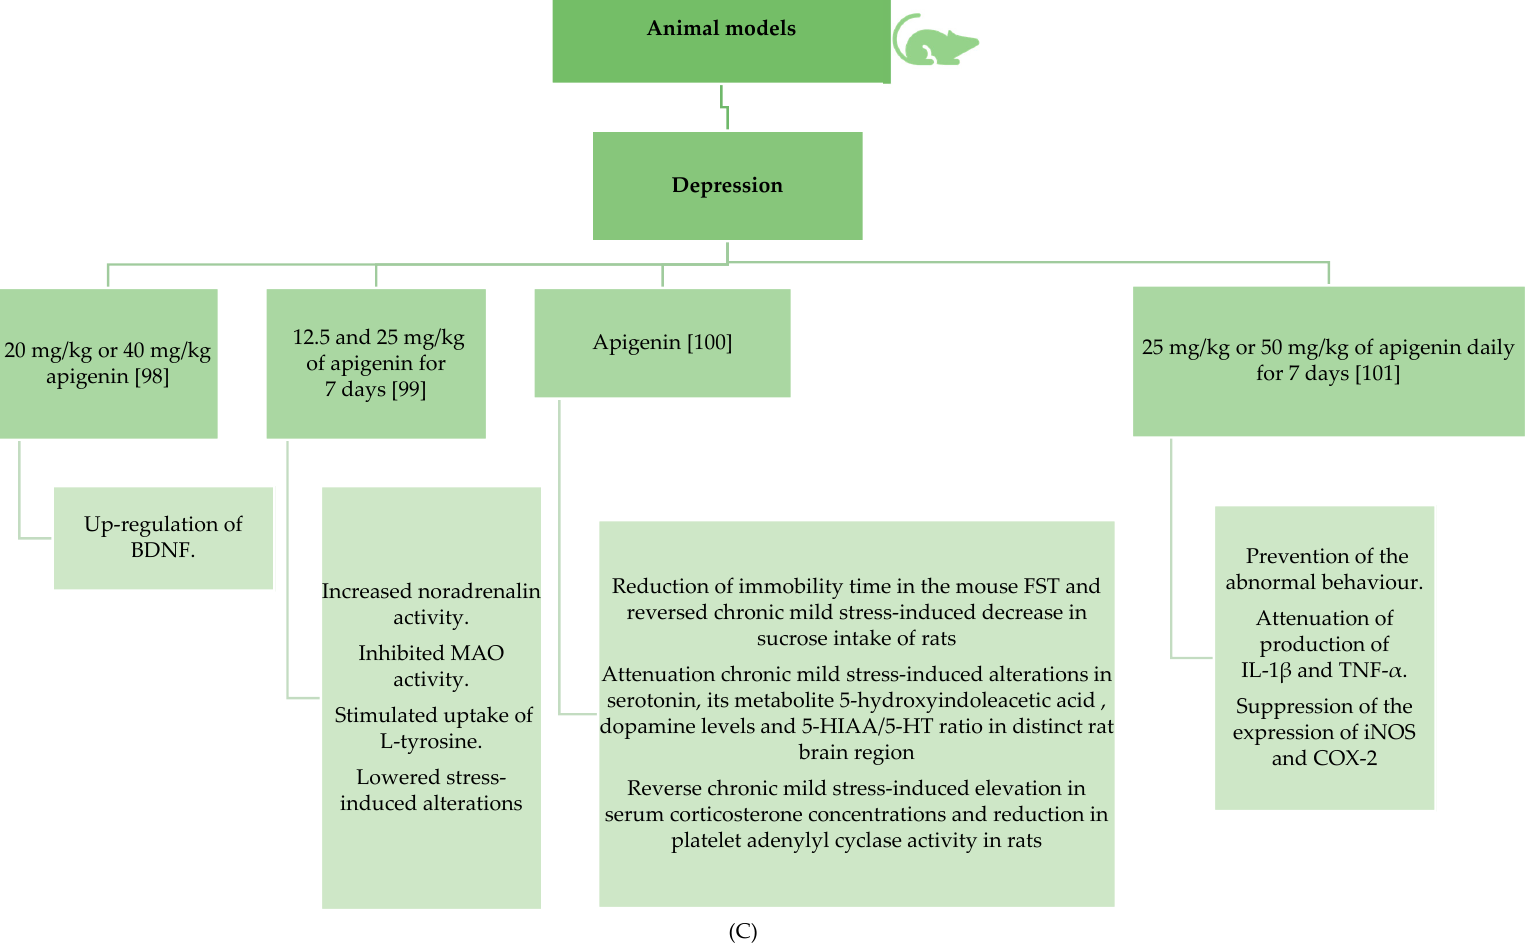
Figure 4. ( A ) Animal model studies involving apigenin effects in diabetes and cancer [82–91]. ( B ) Animal model studies involving apigenin effects in Alzheimer’ disease and amnesia [92–97]. ( C ). Animal model studies involving apigenin effects in depression [98–101].